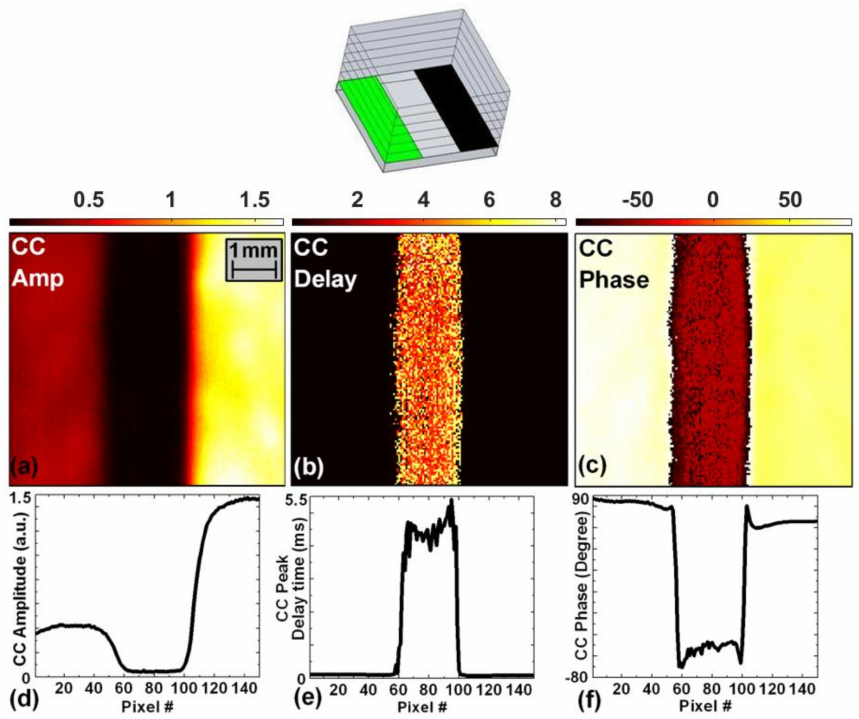
Figure 6. TWR imaging of transparent sample with iso-depth absorbers of different absorption coefficients using ( a ) Cross-correlation (CC) amplitude (unit: a.u.); ( b ) CC peak delay time (unit: millisecond); ( c ) CC phase (unit: degree) and their mean horizontal profiles; ( d – f ), respectively. Chirp parameters: 0.01–1 Hz in 6